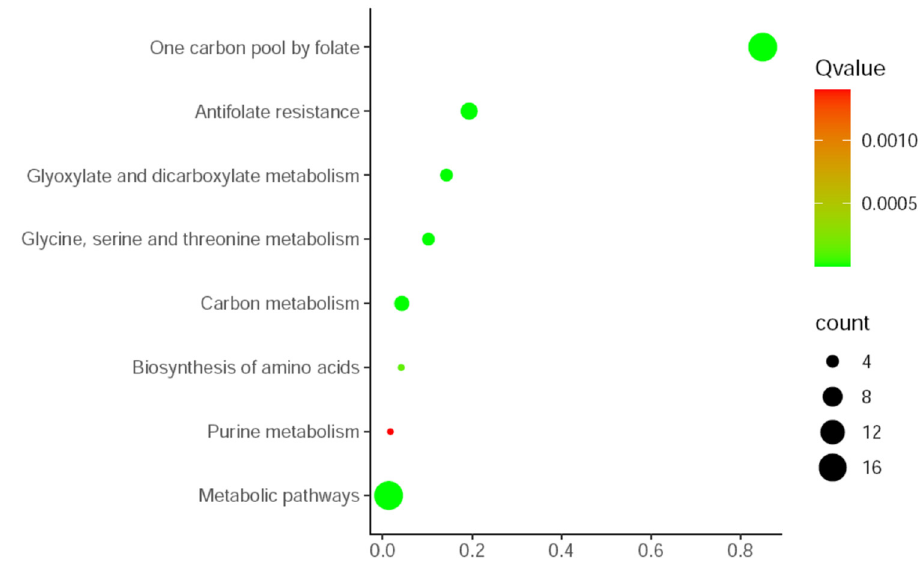
Figure 4: Bubble plot of KEGG pathway enrichment for MTHFD2 gene.